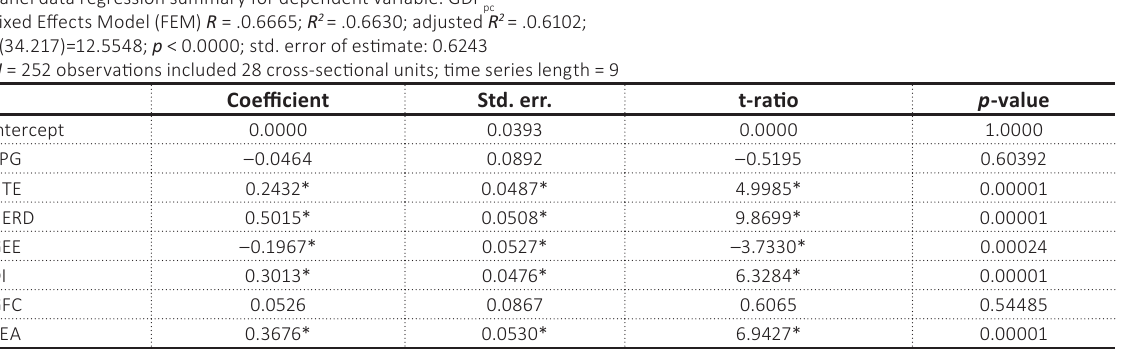
and innovation indicators pc